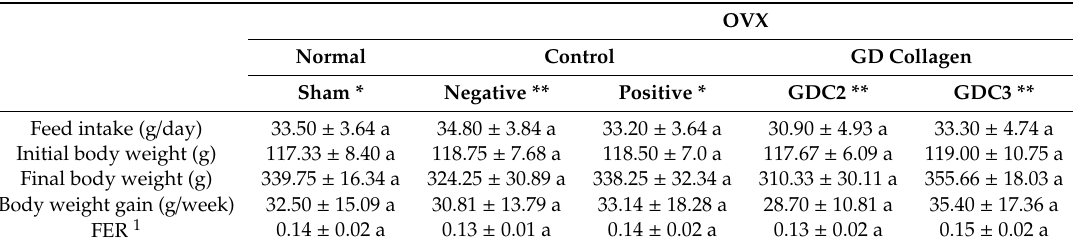
Table 2. Body weight and food